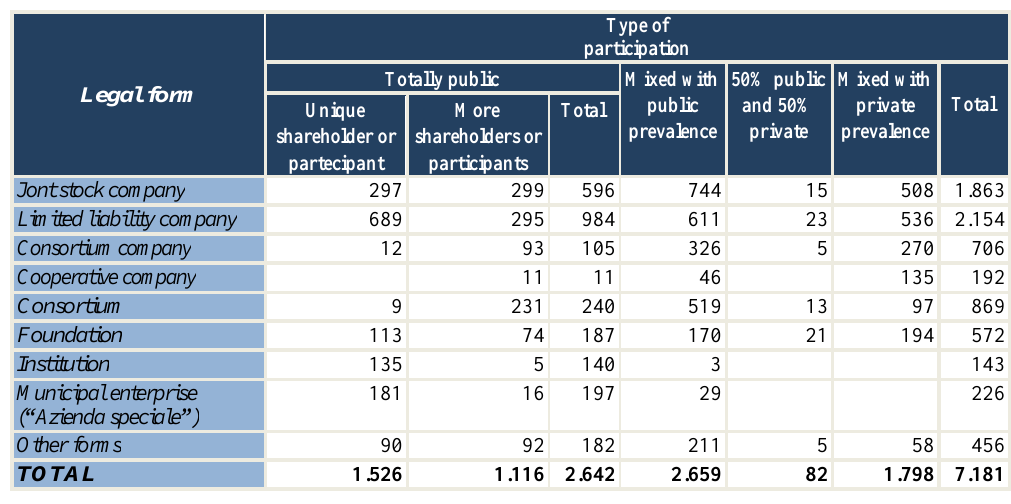
Table 2: Enterprises and other Entities owned by Local Authorities, distinct by Legal Form and Type of